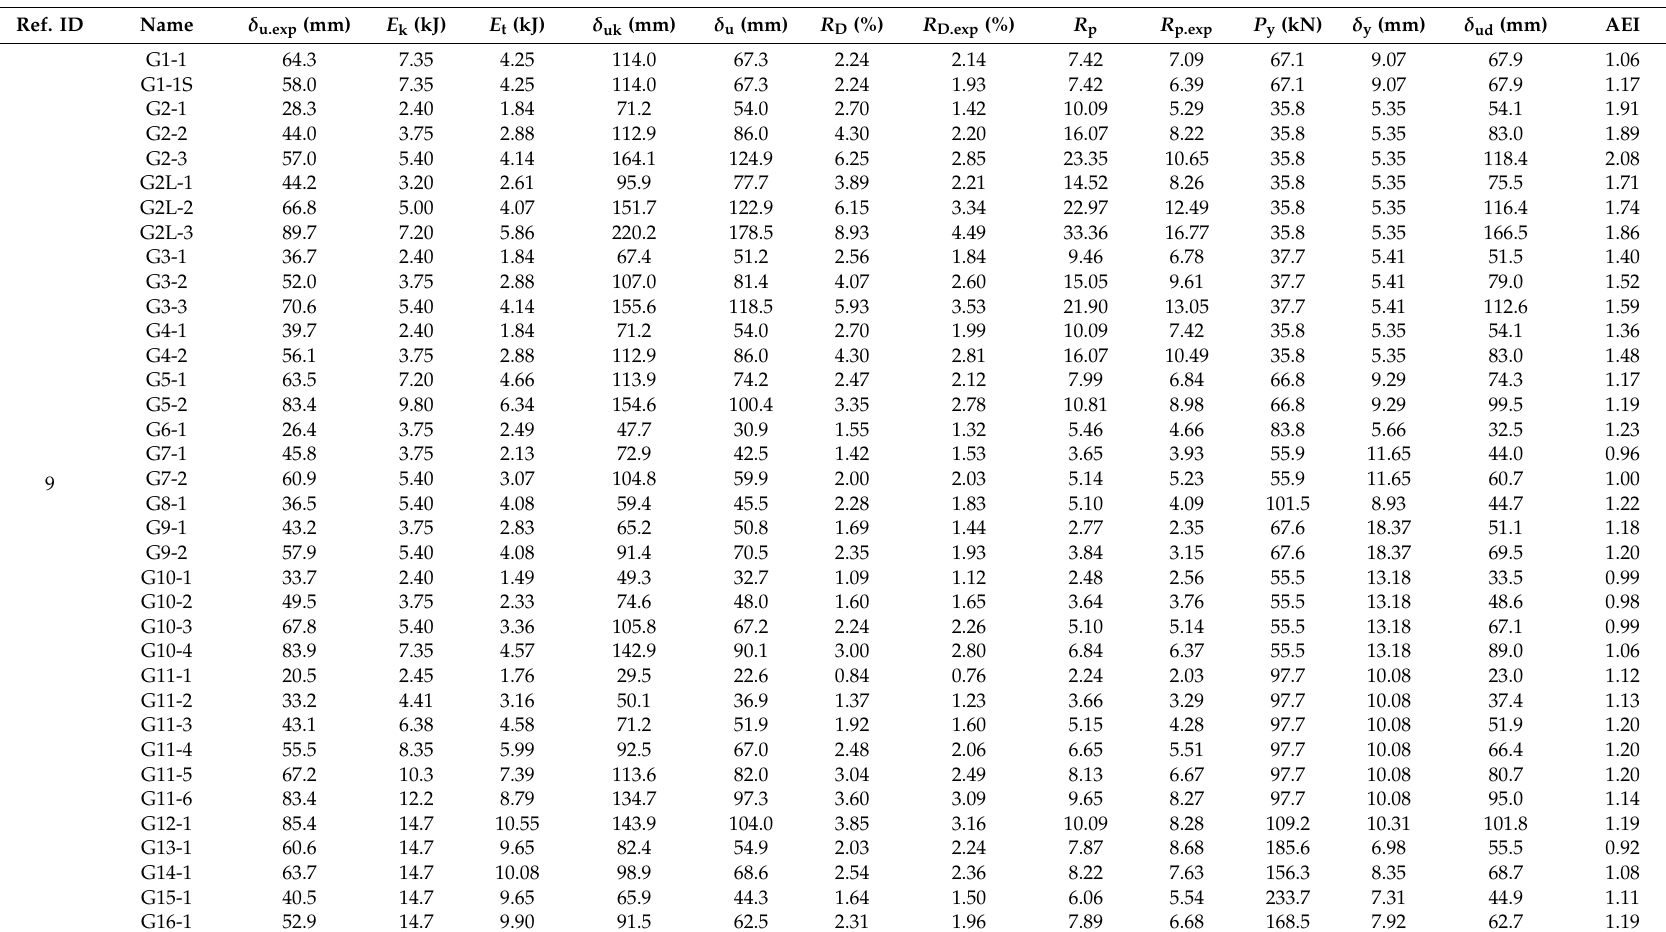
Table A2. Estimated maximum deflection δ u